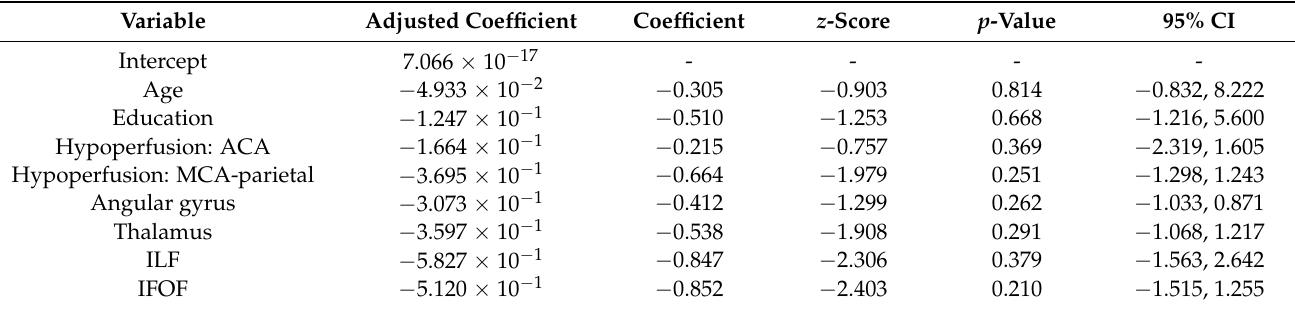
Table 4. Table 4. Summary of LASSO regression output. Table 4. Summary of LASSO regression output.